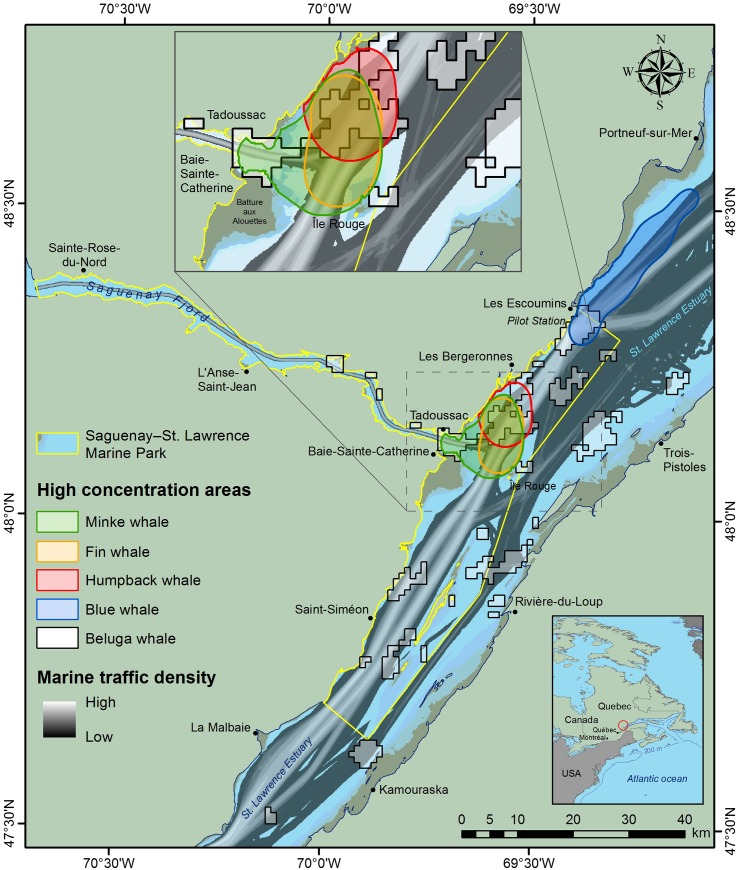
Study area.St. Lawrence Estuary and the Saguenay River, Québec, Canada (Figure created by the authors. Data sources: Canadian Hydrographic Service; Parks Canada; Fisheries and Oceans Canada; Group for Research and Education on Marine Mammals; and ESRI).